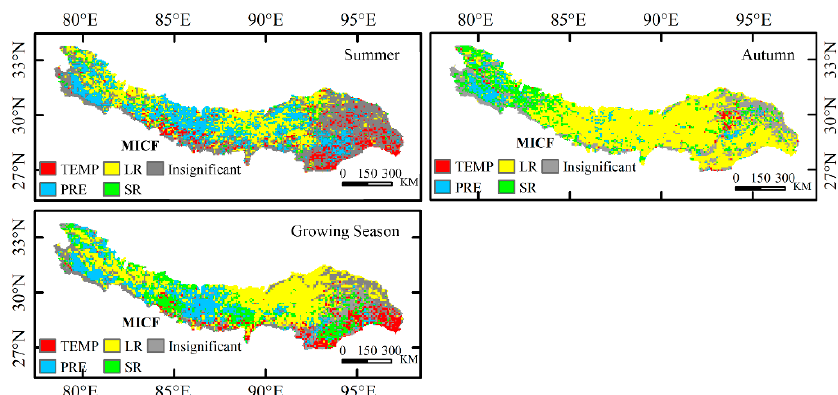
Figure 11. Spatial patterns of partial correlation coefficients between the growing season NDVI and four climatic factors: temperature ( a ), precipitation ( b ), downward long-wave radiation ( c ), and downward short-wave radiation ( d ).